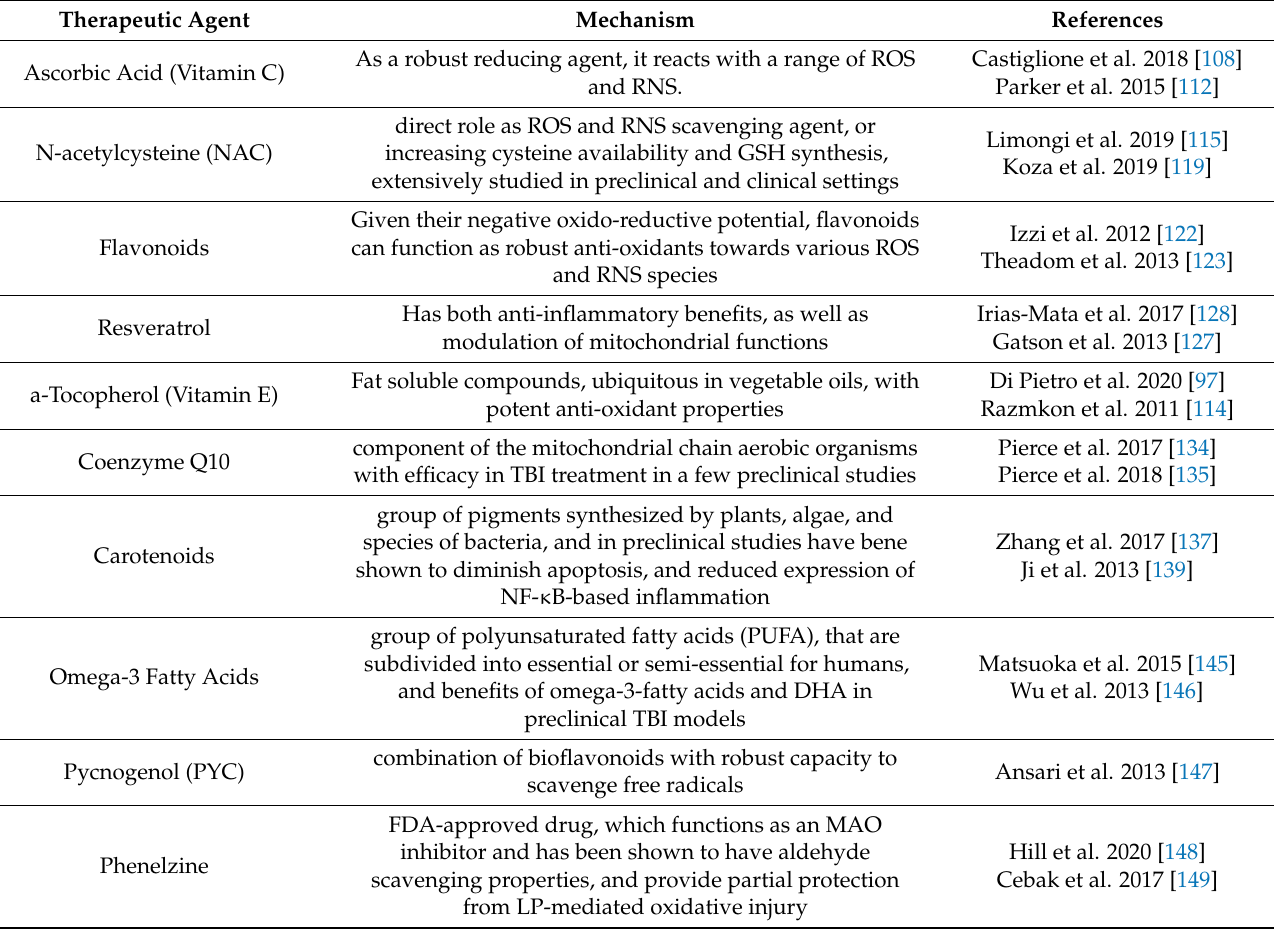
Table 2. Outlines a number of reported therapeutic agents used in treatment of TBI-induced oxida- tive